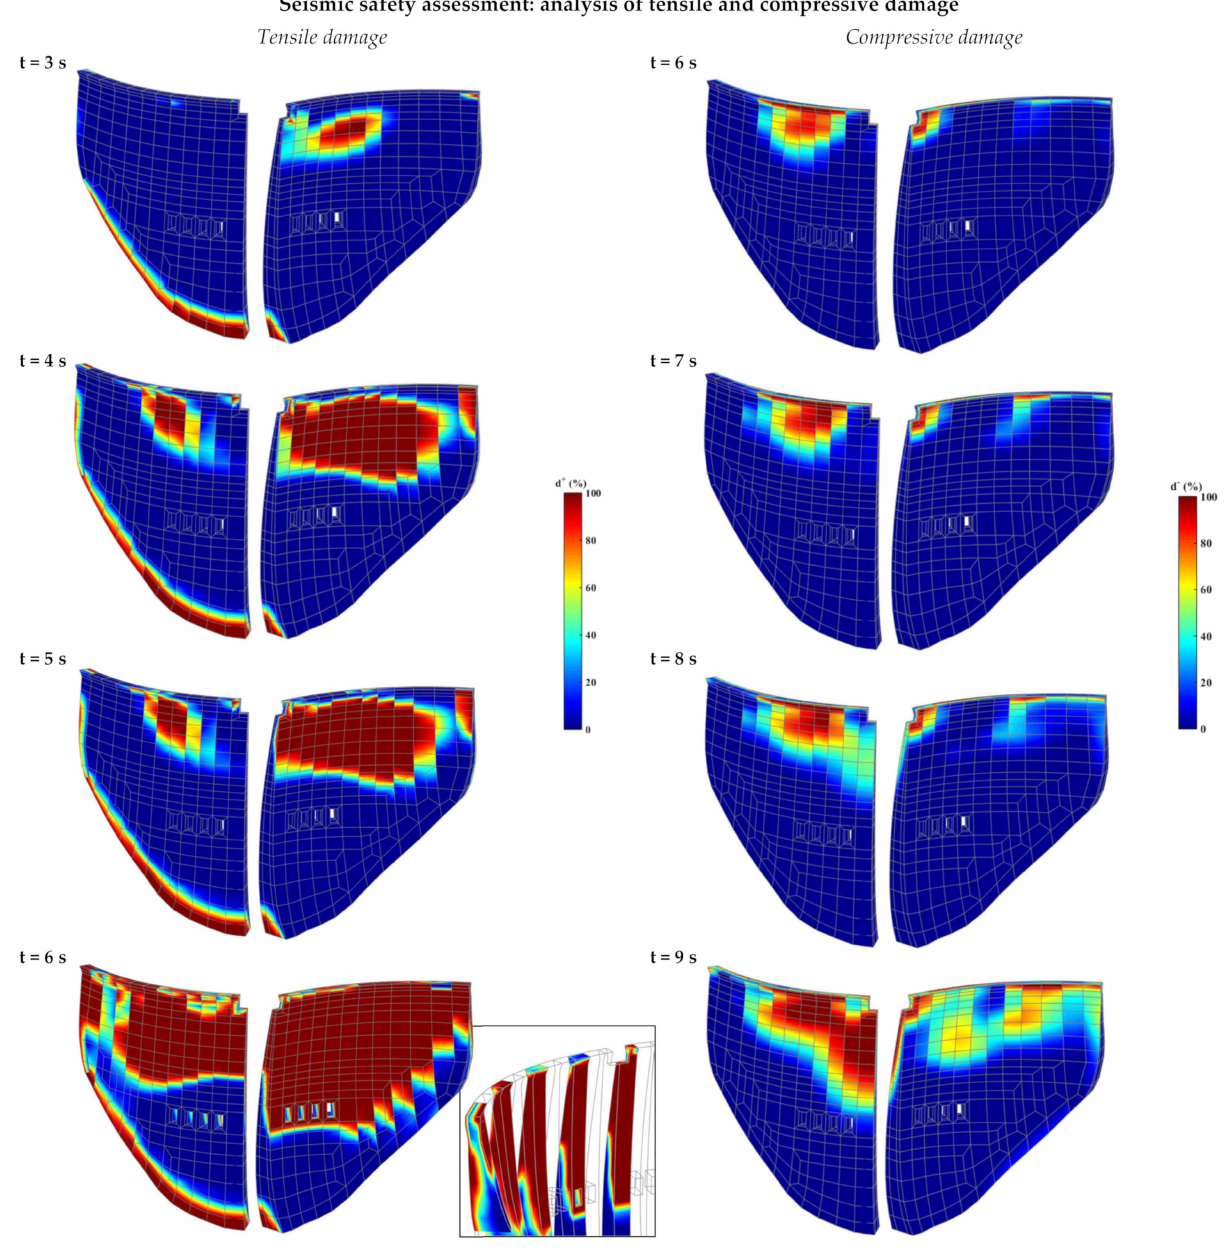
Figure 14. Seismic safety assessment of Cahora Bassa Dam: evolution of tensile and compressive damage for increasing acceleration